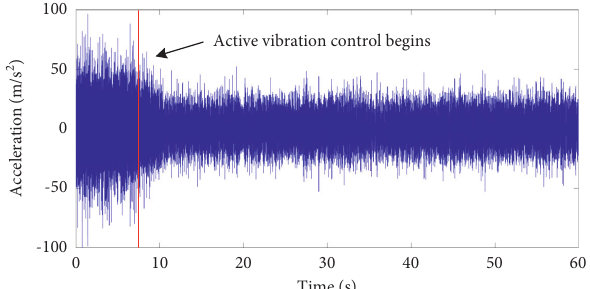
Figure 14: Time-domain control of vibration at 1200rpm.